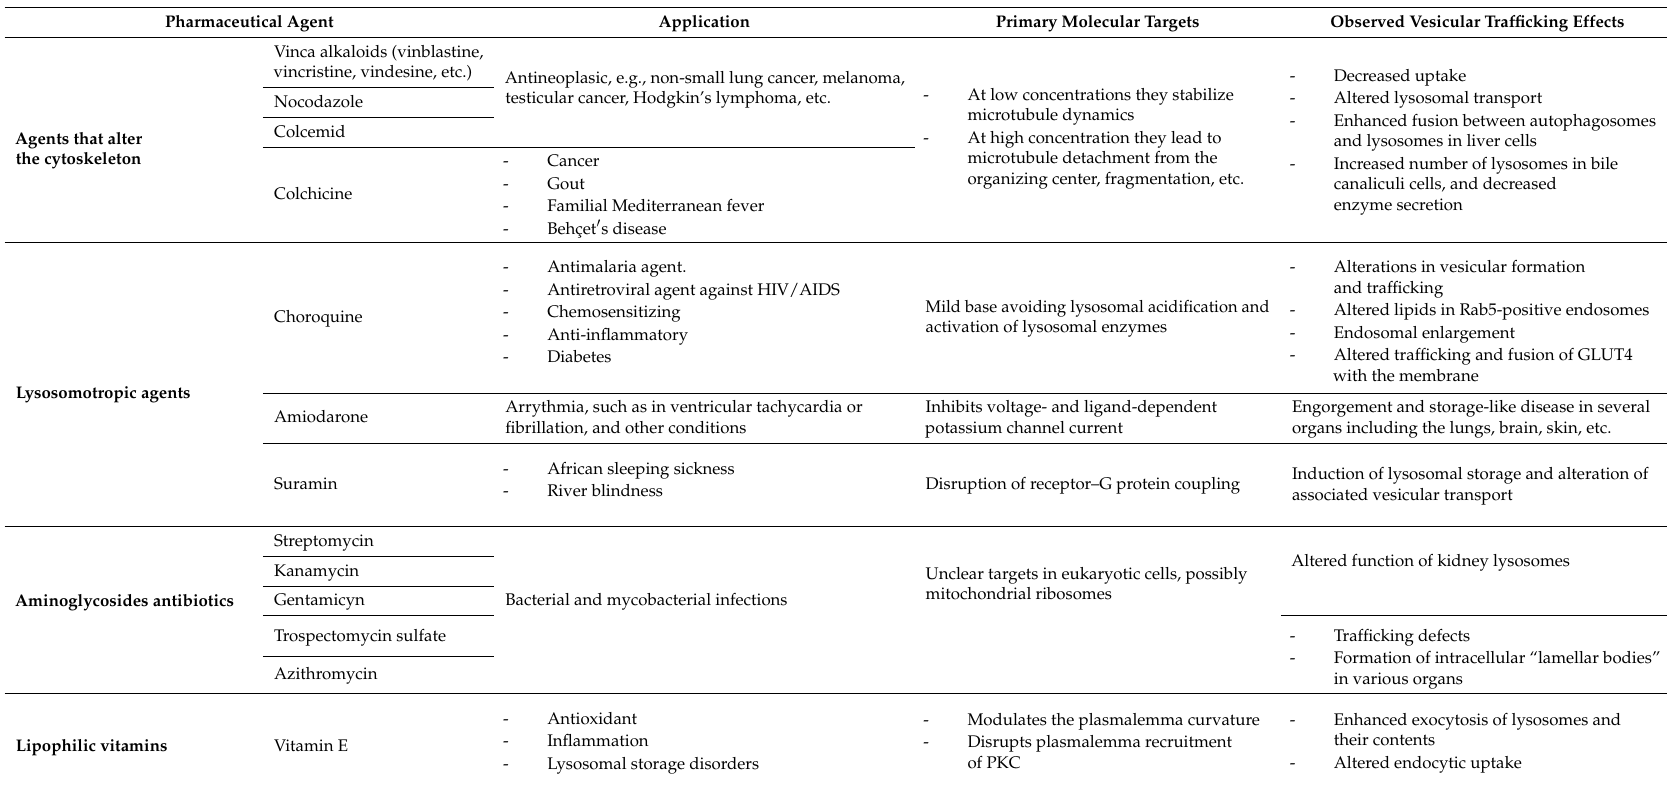
Table 2. Examples of clinical pharmaceutical agents effecting vesicular